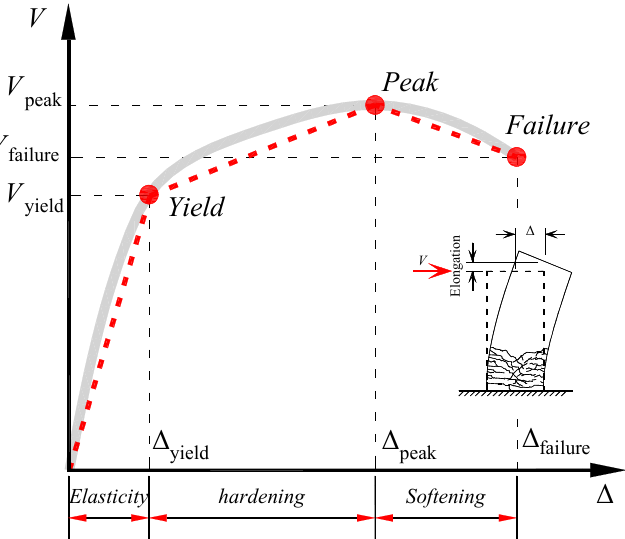
Figure 3. Lateral load–top displacement relationship (grey solid line) and classic backbone (red circle markers and dashed line) of cast-in-place shear wall.